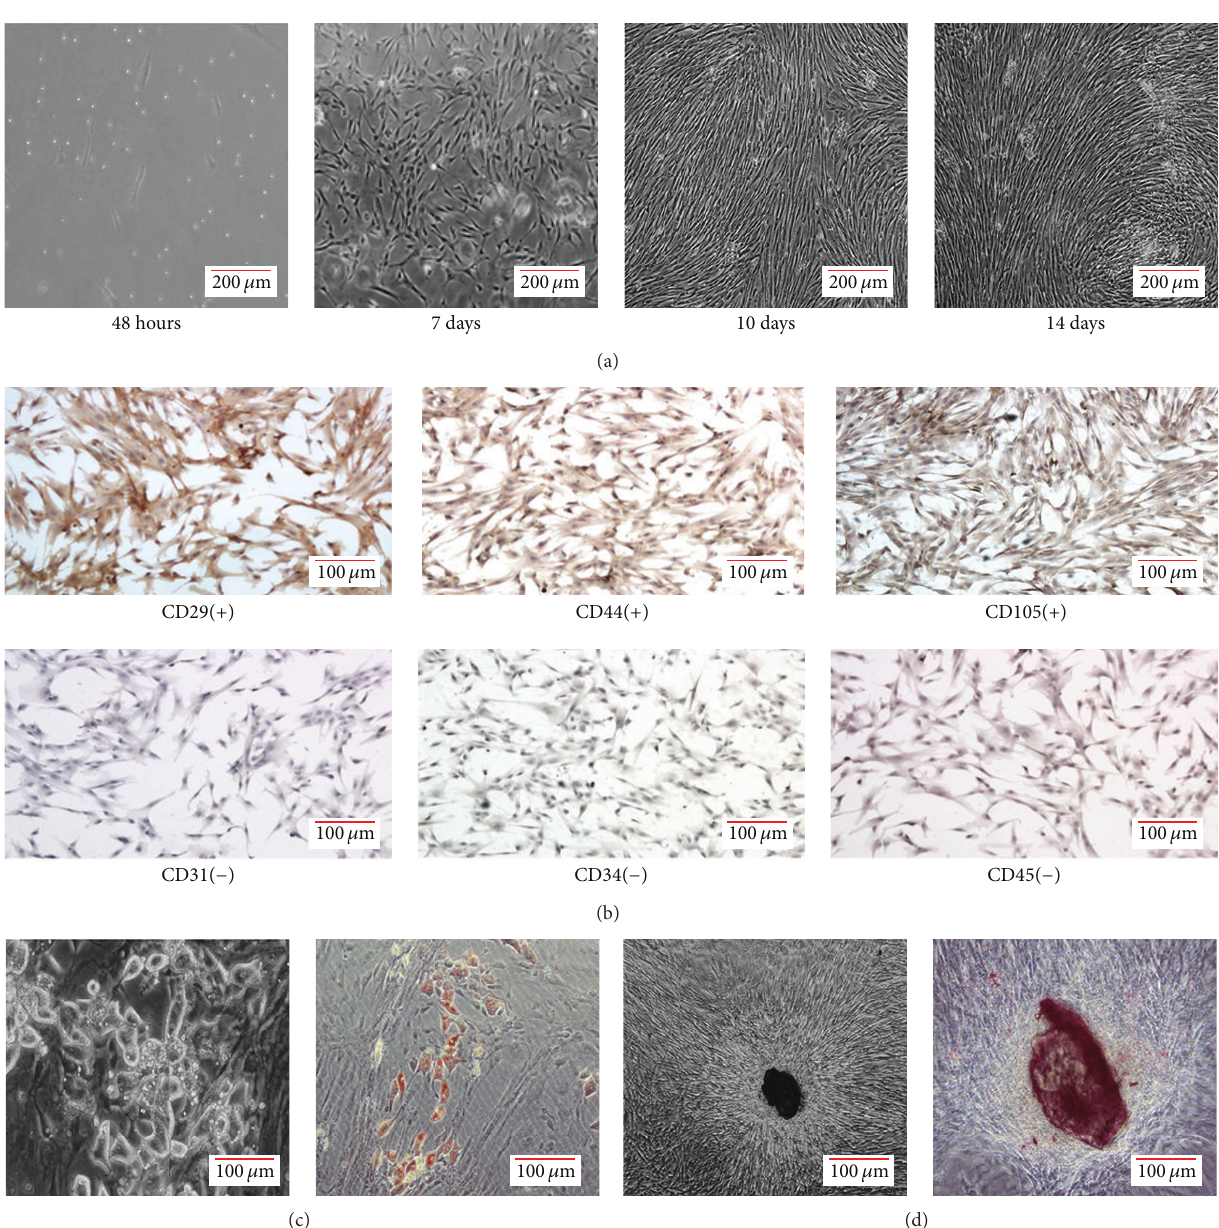
Figure1:Isolation,culture,andidentificationofhUCMSCs.(a)PrimarymesenchymalstemcellsisolatedfromhumanWharton’sjellyformed colonies after 7 days, reached confluency after 10 days, and were in a vortex-like arrangement after 14 days. (b) The adherent cells were stained positively for mesenchymal markers CD29, CD44, and CD105 but were negative for hematopoietic lineage markers CD34 and CD45 and endothelial cell marker CD31. (c) After adipogenic induction for 2 weeks, vacuole-like changes were observed under a microscope (left, × 40), and the cells were stained by oil red O (right). (d) After osteogenic induction, refractile substances were observed in cell colonies (left, × 40), and small round nodules were detected by Alizarin red S staining